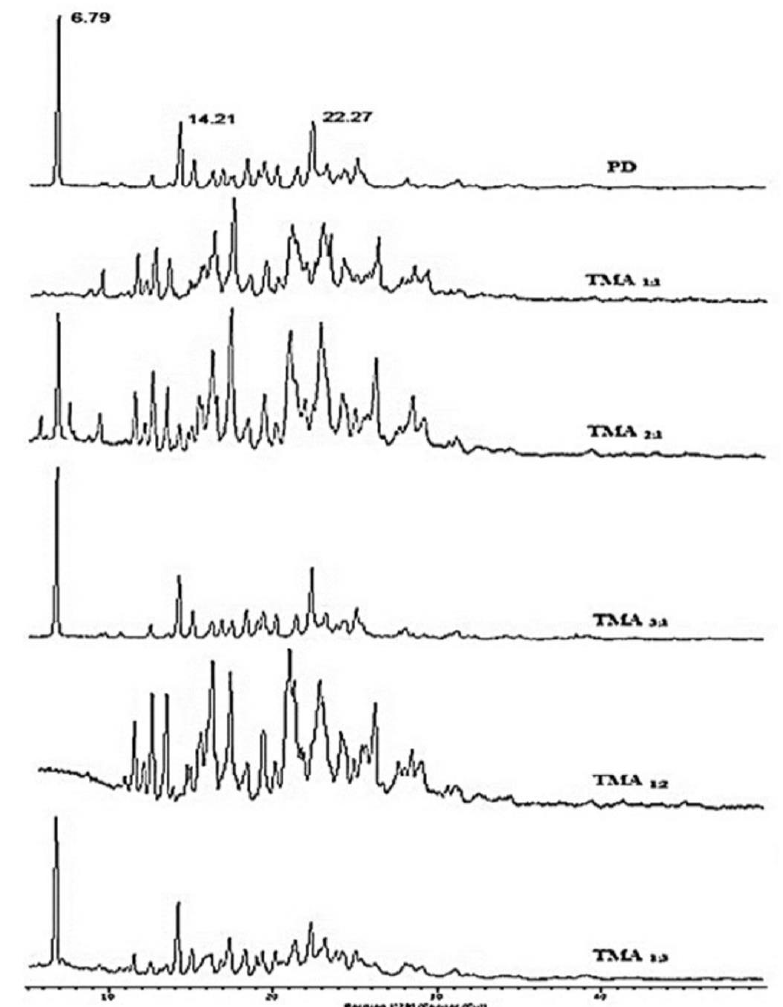
Figure 10. XRD study of telmisartan (PD) and prepared telmisartan-maleic acid cocrystals. The crystal size of the prepared cocrystals was also determined from PXRD data using Scherrer’s formula. This revealed that, for pure telmisartan, the average crystallite size was 893.51 ± 42.82 nm, whereas the average crystallite size of telmisartan-maleic acid cocrystals was found within the range of 489.86 ± 45.55 nm to 306.10 ± 31.09 nm (Figure 11). It was also interesting to observe a proportional relationship between crystallite size and solubility. When the crystallite size was less, the solubility was found to be greater. The maximum solubility was observed with TMA 1:2 (i.e., 46.78 ± 3.48 µ g/mL), where the crystallite size was lowest (i.e., 306.10 ± 31.09 nm) (Figure 11). Crystallite size also has a significant impact on drug dissolution. When the crystallite size was larger, the dissolution was found to be lesser, whereas, with a smaller crystallite size, the dissolution was greater. Though the size of the crystal was smaller with TMA 1:2 as compared with other cocrystal batches, the dissolution was found to be the maximum. This may be because a reduction of crystal size helps to increase the effective surface area, allowing more solvent to come in contact with it, as well as improved wettability of the drug in the presence of solvents, which increases the solubility and dissolution of poorly soluble telmisartan [41].